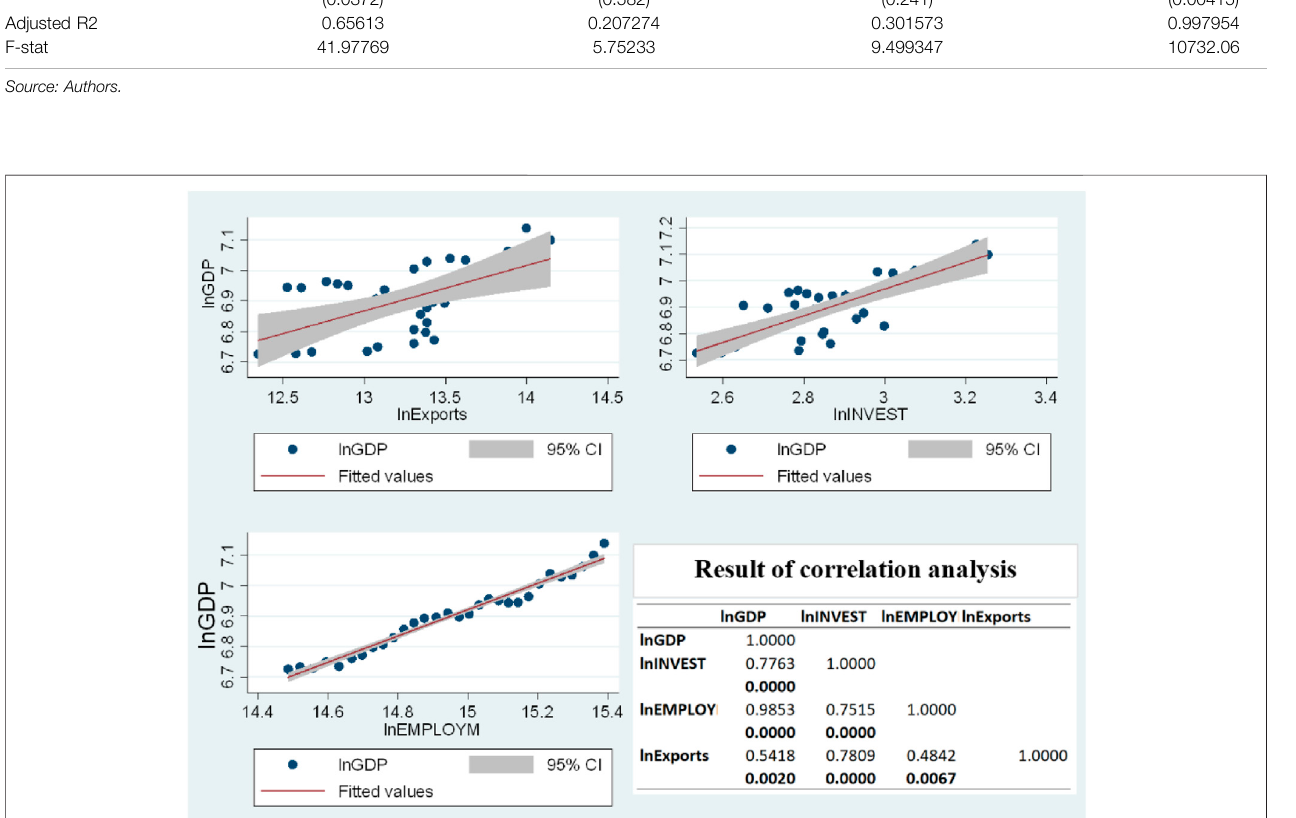
Frontiers in Environmental Science |